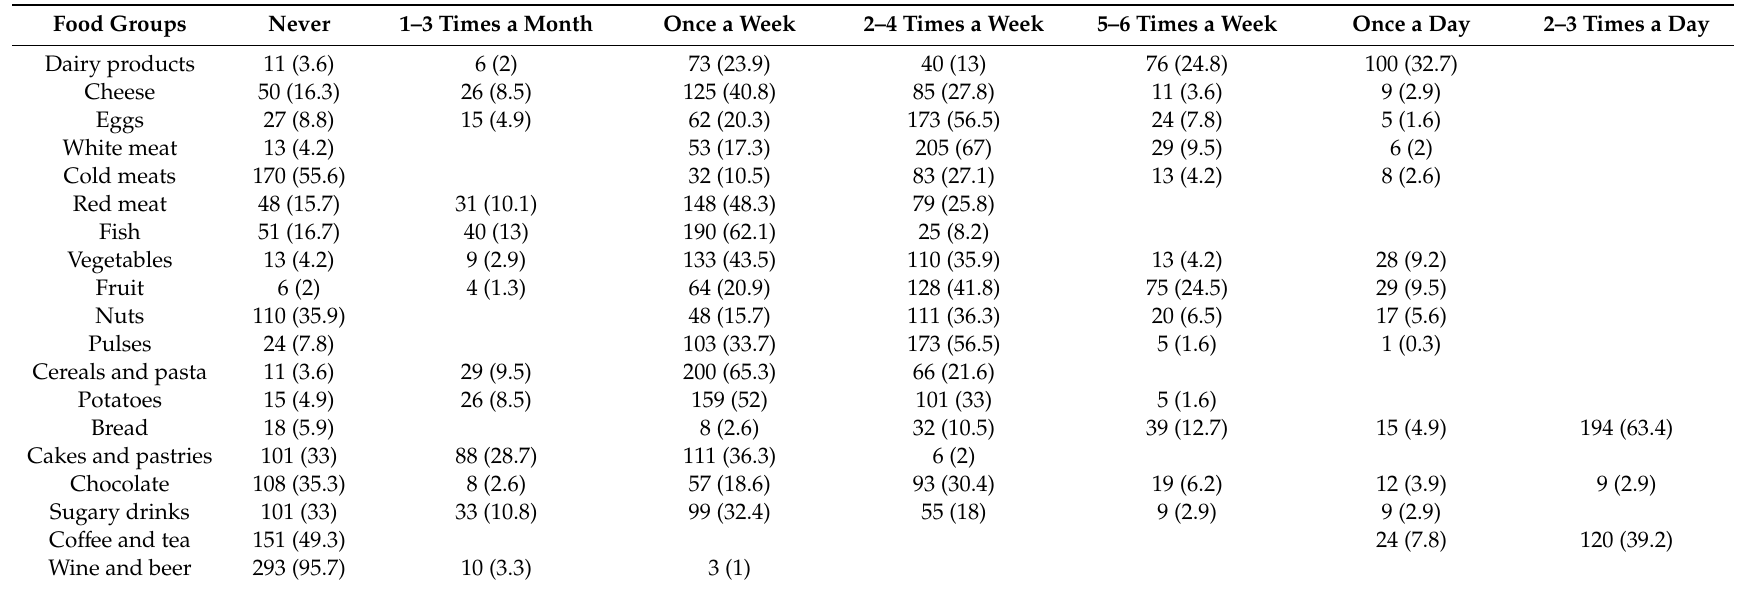
Table 4. Consumption of food groups (frequencies and